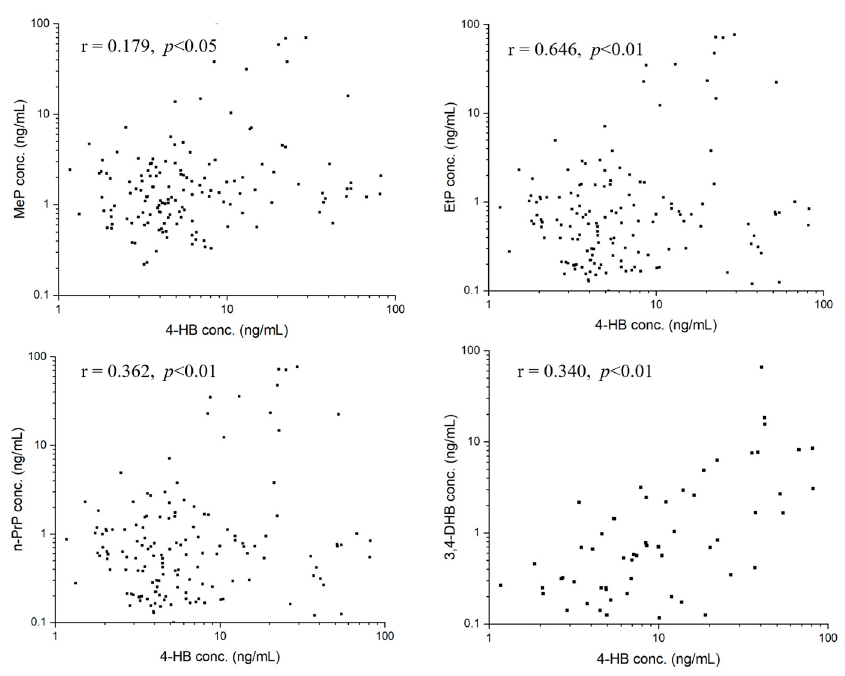
Figure 4. Correlations between 4-HB and MeP, 4-HB and EtP, 4-HB and n-PrP, 4-HB and 3,4-DHB in seminal plasma.